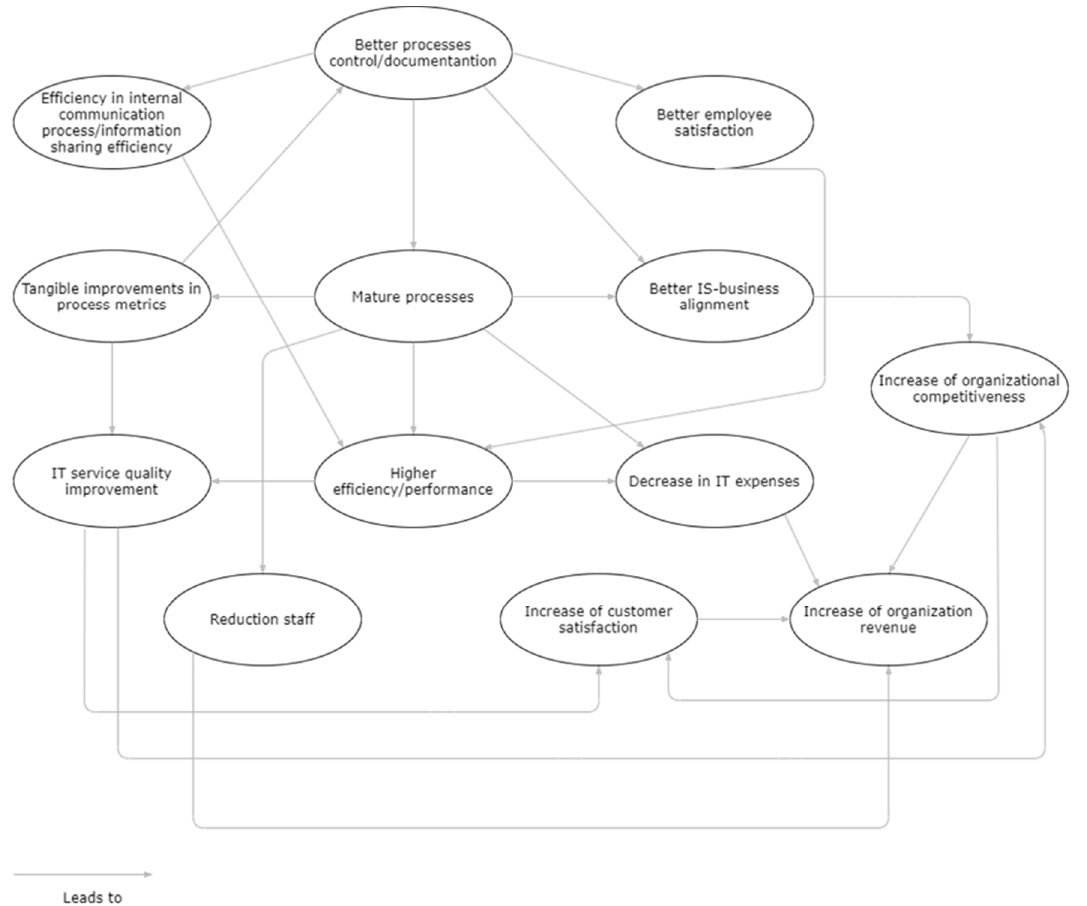
Figure 7. ITSM Benefits Conceptual Model.